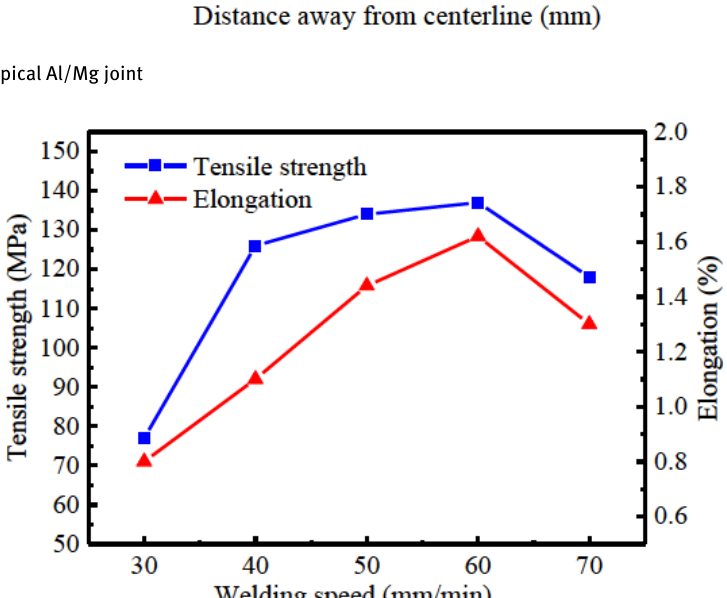
Fracture surface morphologies of the typical Al/Mg joint at the welding speed of 60 mm/min were shown in Figure 10. All the fracture surface morphologies through the thickness direction were featured by the cleavage fea- ture (Figures 10b-10d), illustrating the typical brittle frac- ture because of the occurrence of the IMCs. The fracture morphologies in Figure 10 were consistent with the frac- ture location of the Al/Mg joint in Figure